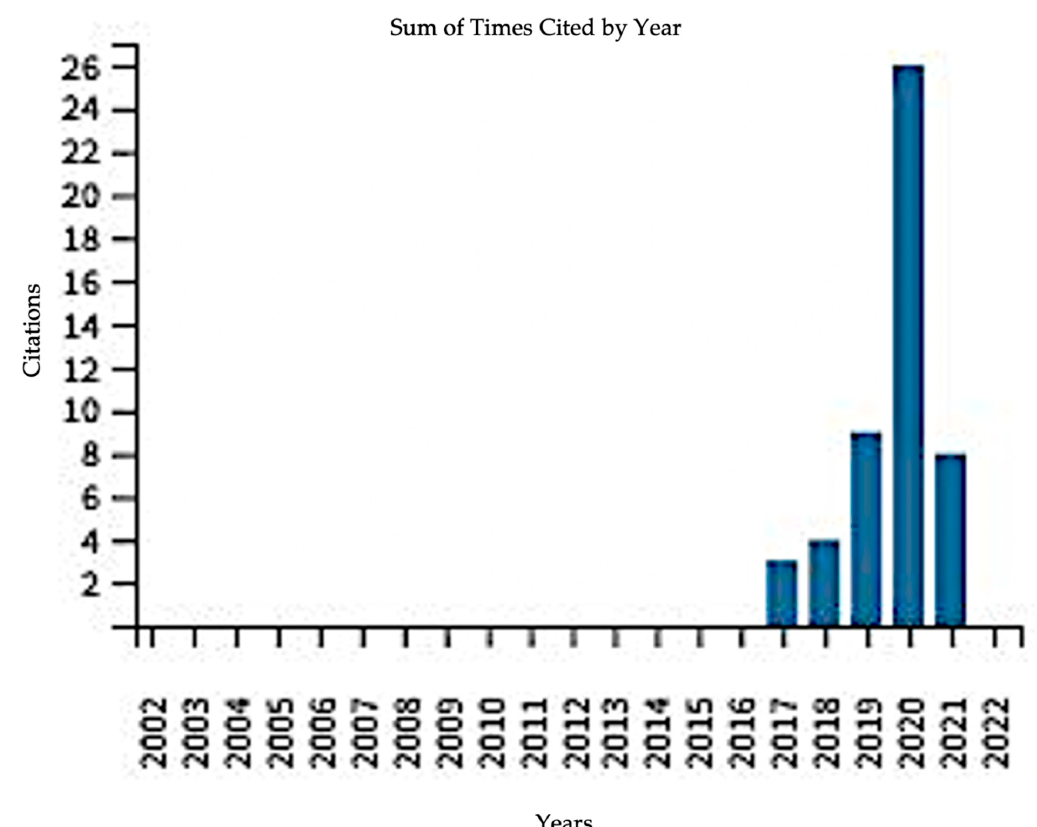
Figure 17. Citation report for 14 results from Web of Science Core Collection.